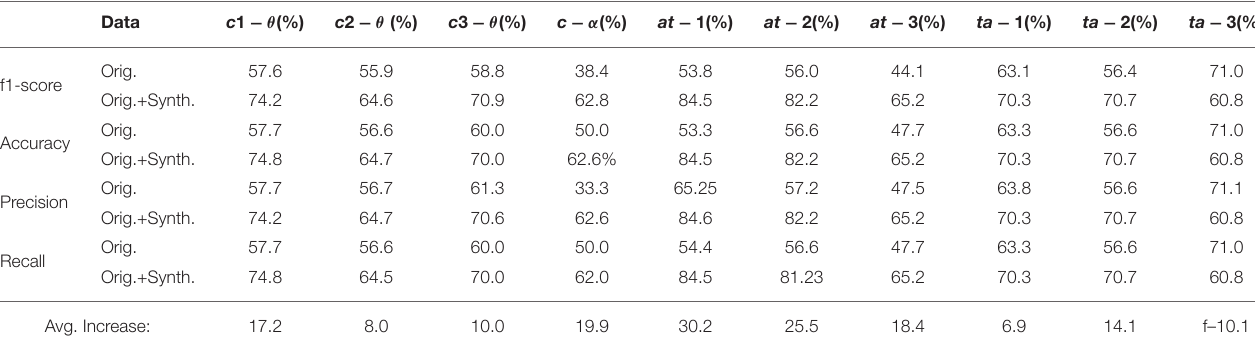
TABLE 5 | Models performance increase across mental workload indexes between original dataset and dataset combined with synthetic data. Data Orig. f1-score Orig.+Synth. Orig. Accuracy Orig.+Synth. Orig. Precision Orig.+Synth. Orig. Recall